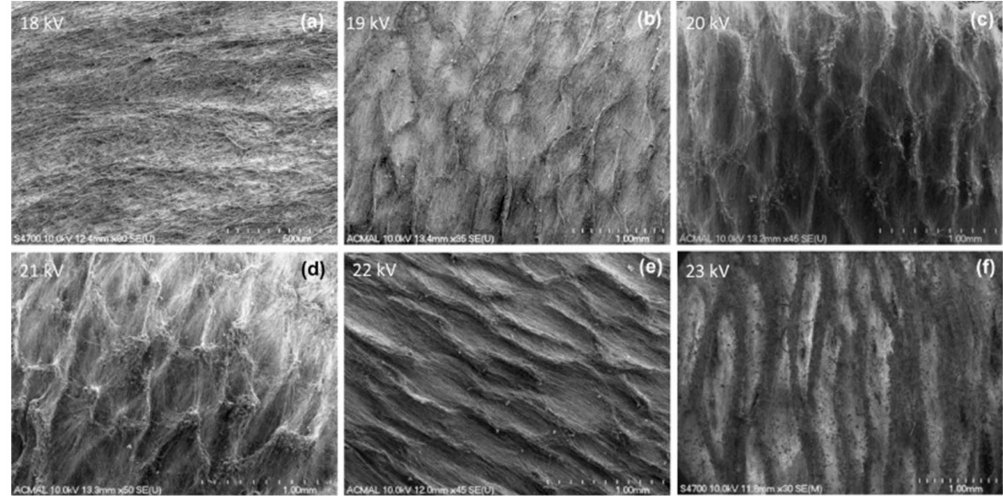
Figure 15. Field Emission Scanning Electron Microscope (FESEM) image of the di ff erent morphologies obtained using a synthetic polymer blend of PCL and PANI at di ff erent voltages. The sca ff olds had no significant change in surface chemistry but had di ff erent mechanical properties. Reprinted with permission from [104], Elsevier,